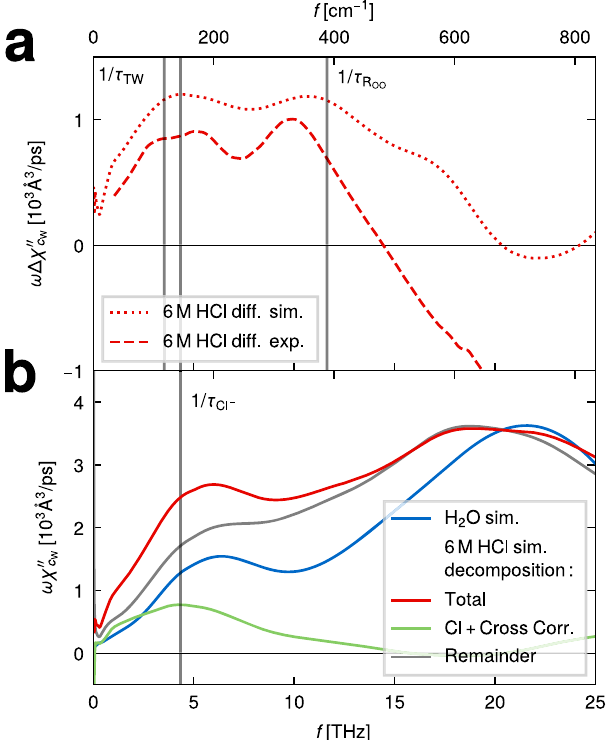
Fig. 6 Absorption spectra in the THz regime. a Experimental THz/Fourier- transform infrared (THz/FTIR) difference spectra of 6 M HCl solution (red broken line) compared to the difference spectrum from ab initio molecular dynamics (MD) simulations (red dotted line). b The simulated 6 M HCl spectrum (red solid line) is decomposed into a chloride-ion contribution (green solid line, including cross correlations) and the remainder (gray solid line). For comparison the simulated pure-water spectrum (blue solid line) is also shown.